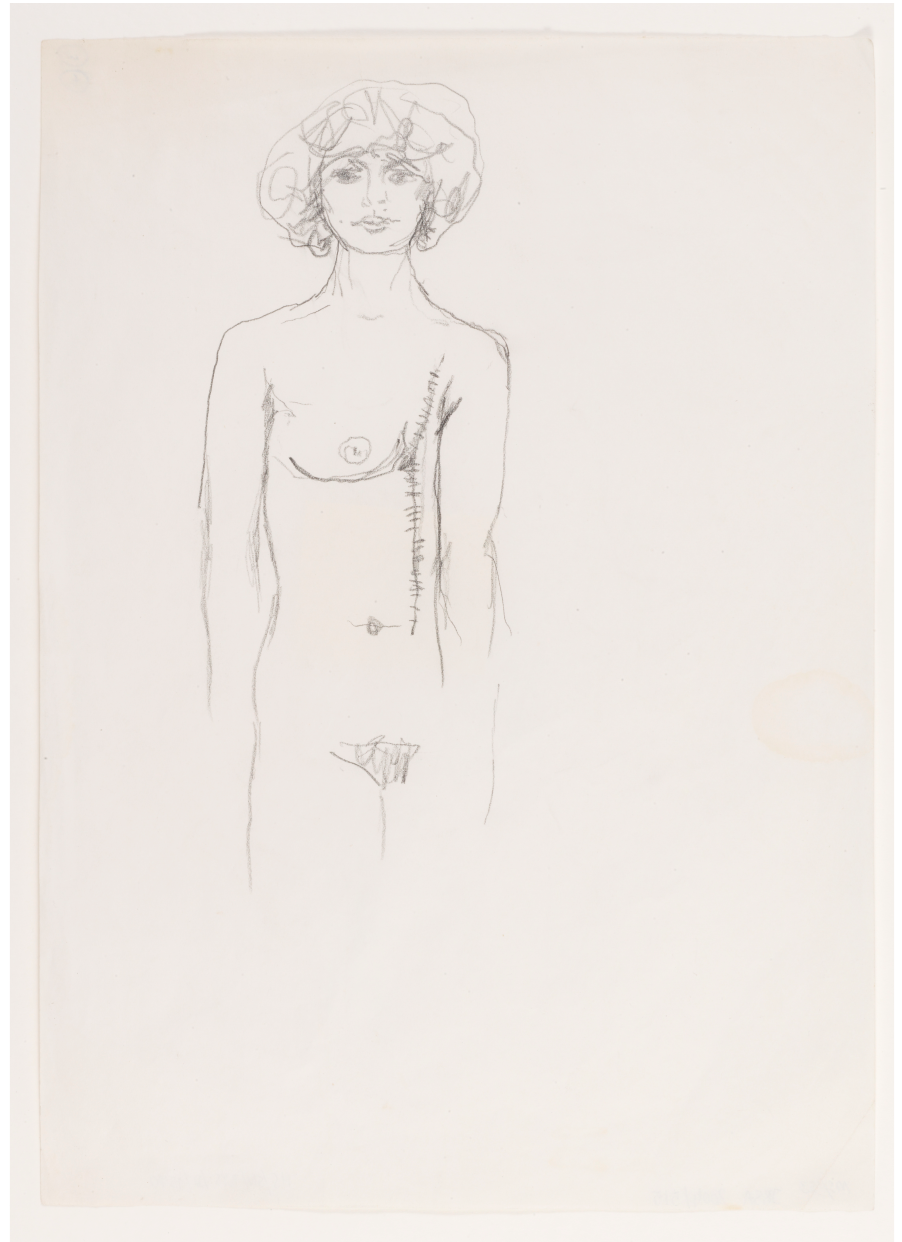
Figure 3. Alina Szapocznikow, Untitled, v. 1971–1972, pencil on copying paper, 29.5 × 21 cm. © ADAGP, Paris. © ADAGP, Paris. Courtesy of The Estate of Alina Szapocznikow/Piotr Stanis- lawski/Galerie Loevenbruck, Paris/Hauser &